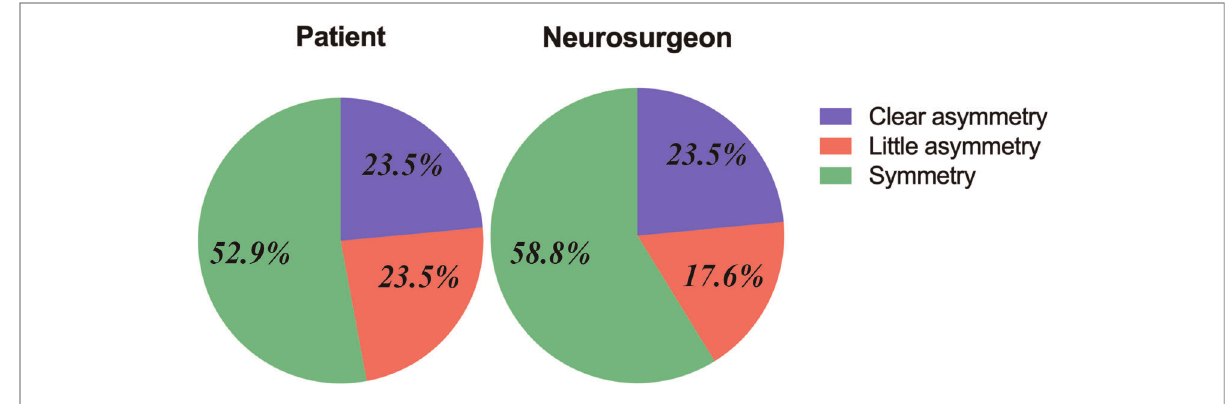
FIGURE 3 Evaluation of esthetic outcome from patients themselves and neurosurgeons and most patients show good esthetic